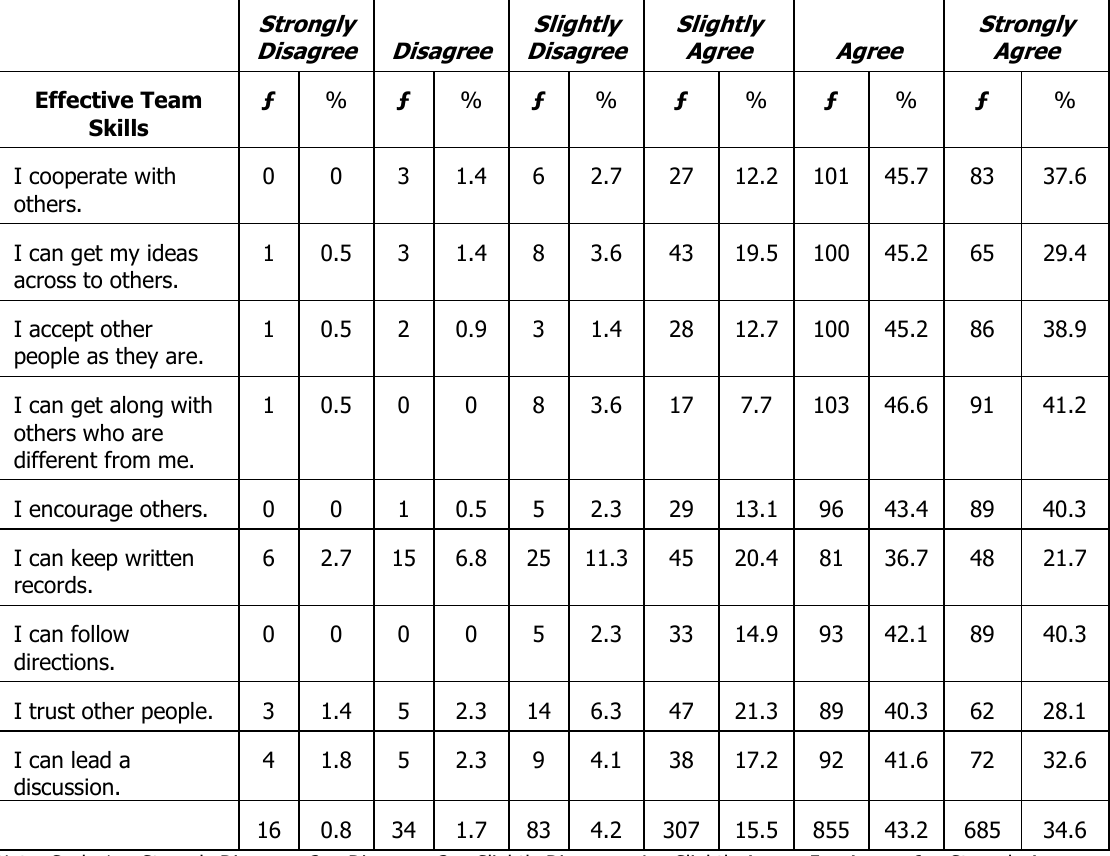
Level of National Youth Service Day and District 11 4-H Leadership Lab Participants’ Agreement with Effective Team Skills Statements, 2003, n=220 Strongly Disagree Disagree